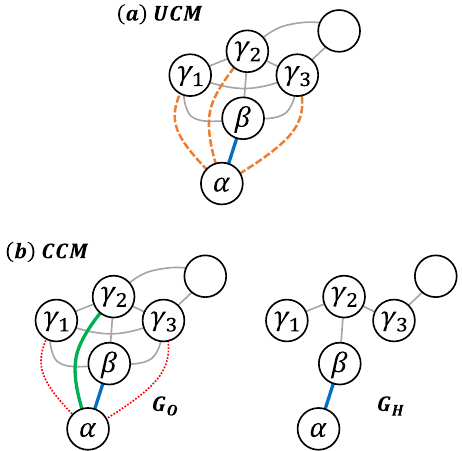
Fig. 1 Two models of network formation via node copying. a The uniform copying model (UCM), and b the correlated copying model (CCM). The UCM consists of a single layer. The CCM has an observed layer, in which copying takes place, G O , and a hidden layer, G H . For both models, a new node α (the daughter) is added to the existing network (nodes connected by grey edges) and forms a random link (blue) to a target node, β (the mother). a In the UCM, there is a uniform probability, p , of forming an edge to each of β ’ s neighbours ( γ 1 , γ 2 , γ 3 ; orange dashed edges). b In the CCM, copied edges are added to the observed network, G O , deterministically. If an edge exists in the hidden network, G H , between node β and node γ j (e.g., the { β , γ 2 } edge), then node α copies that edge in G O (e.g., forming the { α , γ 2 } edge; solid green). If an edge does not exist in G H (e.g., the { β , γ 1 } and { β , γ 3 } edges), the corresponding edges are not copied to G O (red dotted lines). Copied edges are never added to G H